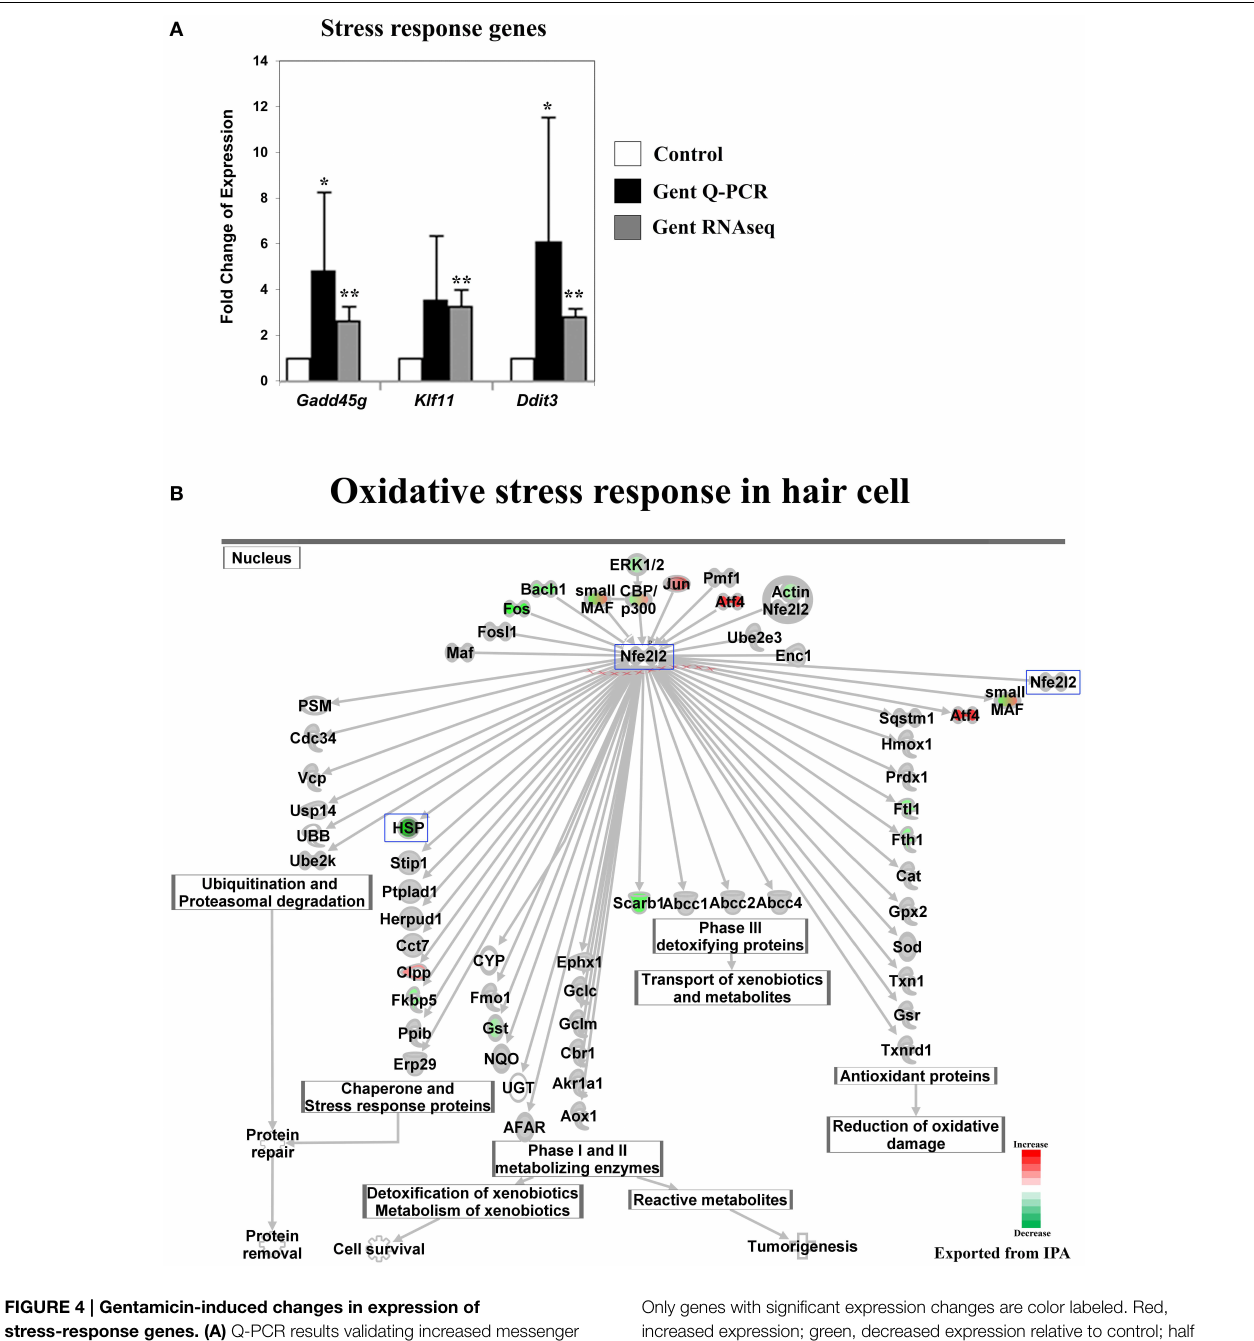
FIGURE 4 | Gentamicin-induced changes in expression of stress-response genes. (A) Q-PCR results validating increased messenger RNA levels in hair cells after gentamicin treatment. Error bar, standard deviation: * p < 0 . 1 ; ** p < 0 . 01 . (B) NRF2-mediated oxidative stress response network with color-coded expression shifts showing the absence of significant induction of oxidative stress response at the transcriptional level.